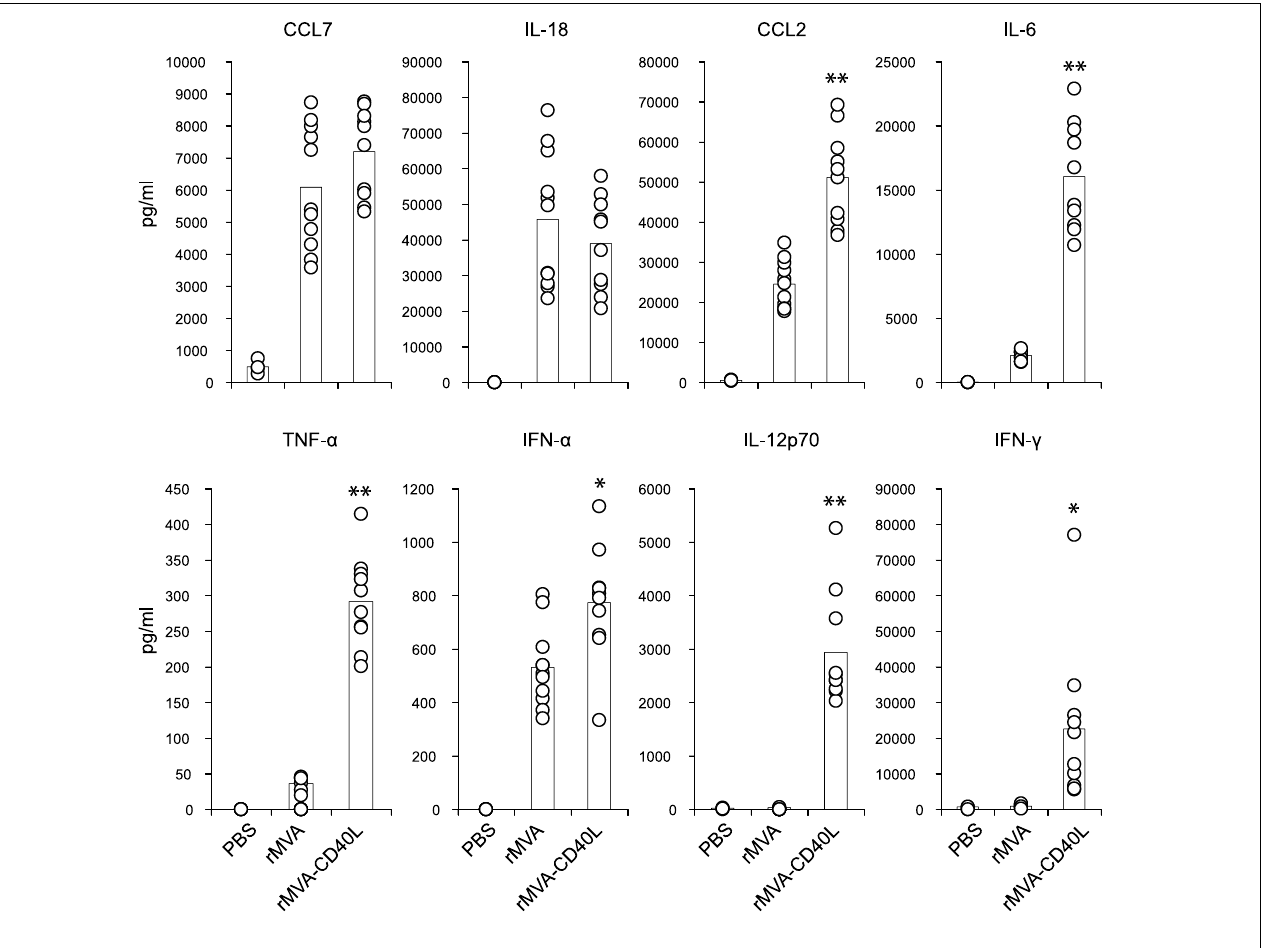
FIGURE 4 | Enhanced systemic cytokine levels after injection of rMVA-CD40L . C57BL/6 mice were treated with PBS, rMVA, or rMVA-CD40L. Six hours after injection, serum cytokine levels were determined by a cytometric bead assay. Note that IL-12p70 was only